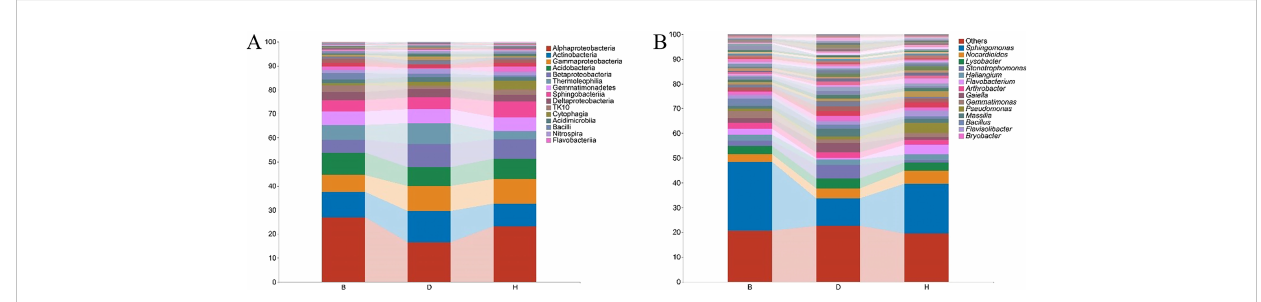
FIGURE 3 Relative abundance of bacterial taxa at the class (A) and genus (B) levels. Small taxa were merged into others with the ASV counts less than 10 for class level. Only top 50 taxa were calculated for genus level and the rest was merged into others. Bar charts were used for visualization with top 15 items labeled.